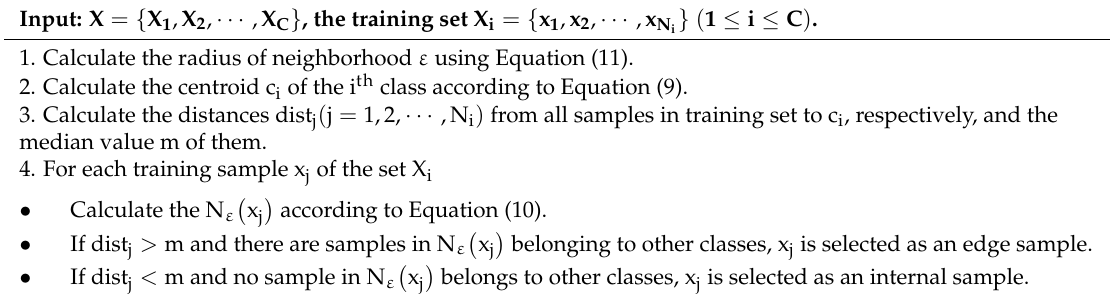
Table 4. The Selection of Internal and Edge